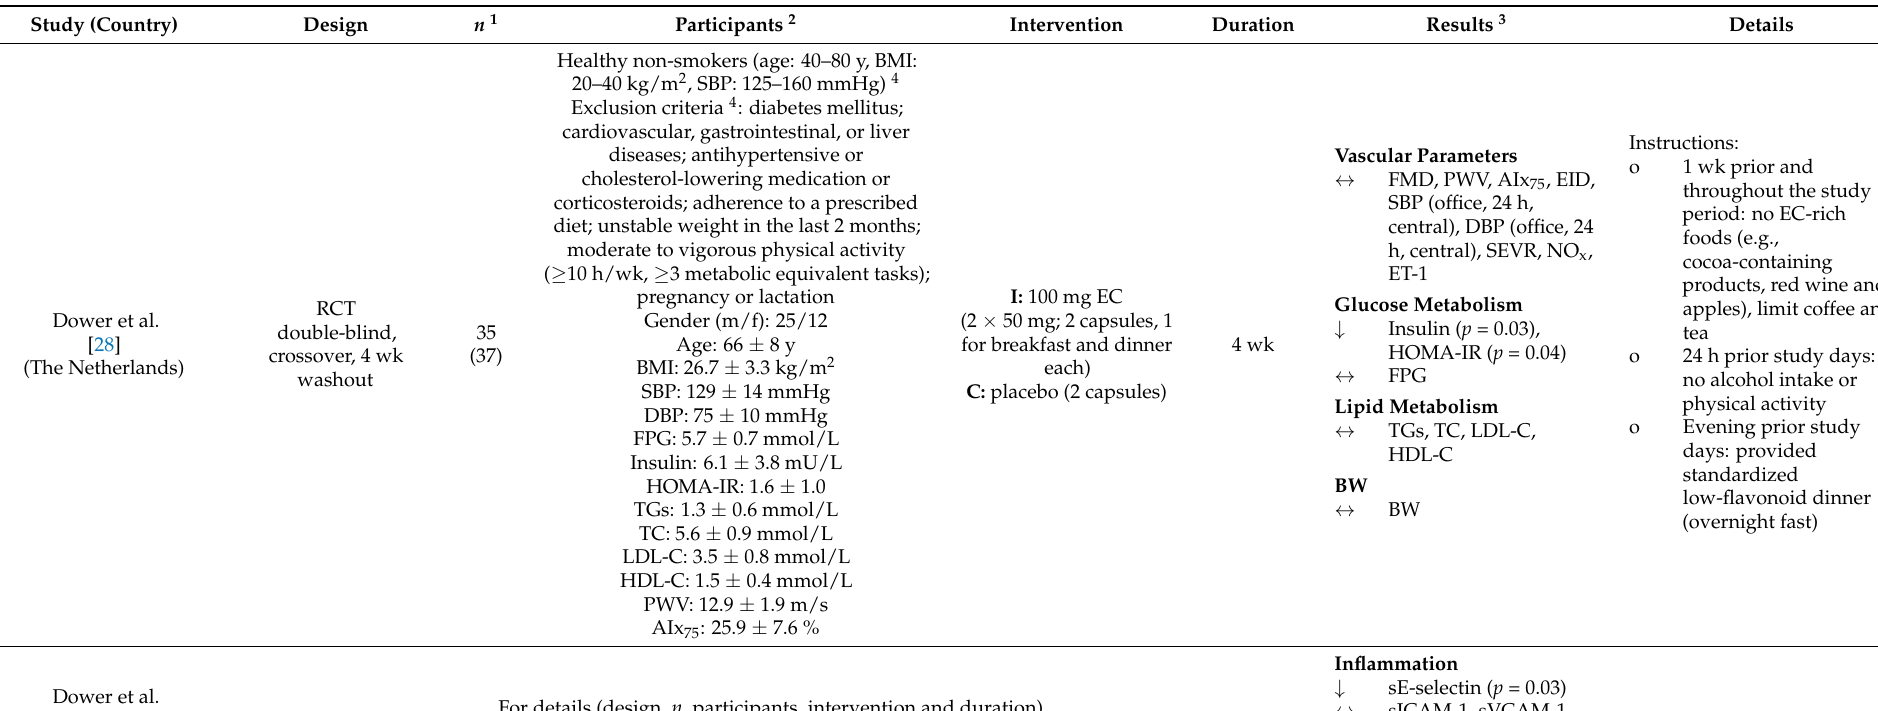
Table 2. Effect of a regular (–)-epicatechin intake on cardiometabolic parameters—results from randomized controlled trials. Study